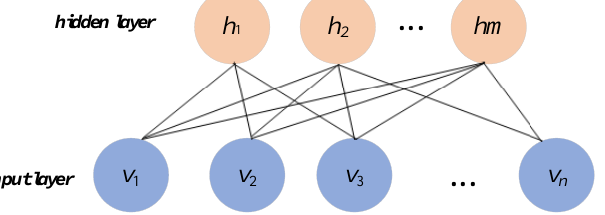
Figure 4. The network structure of the RBM.